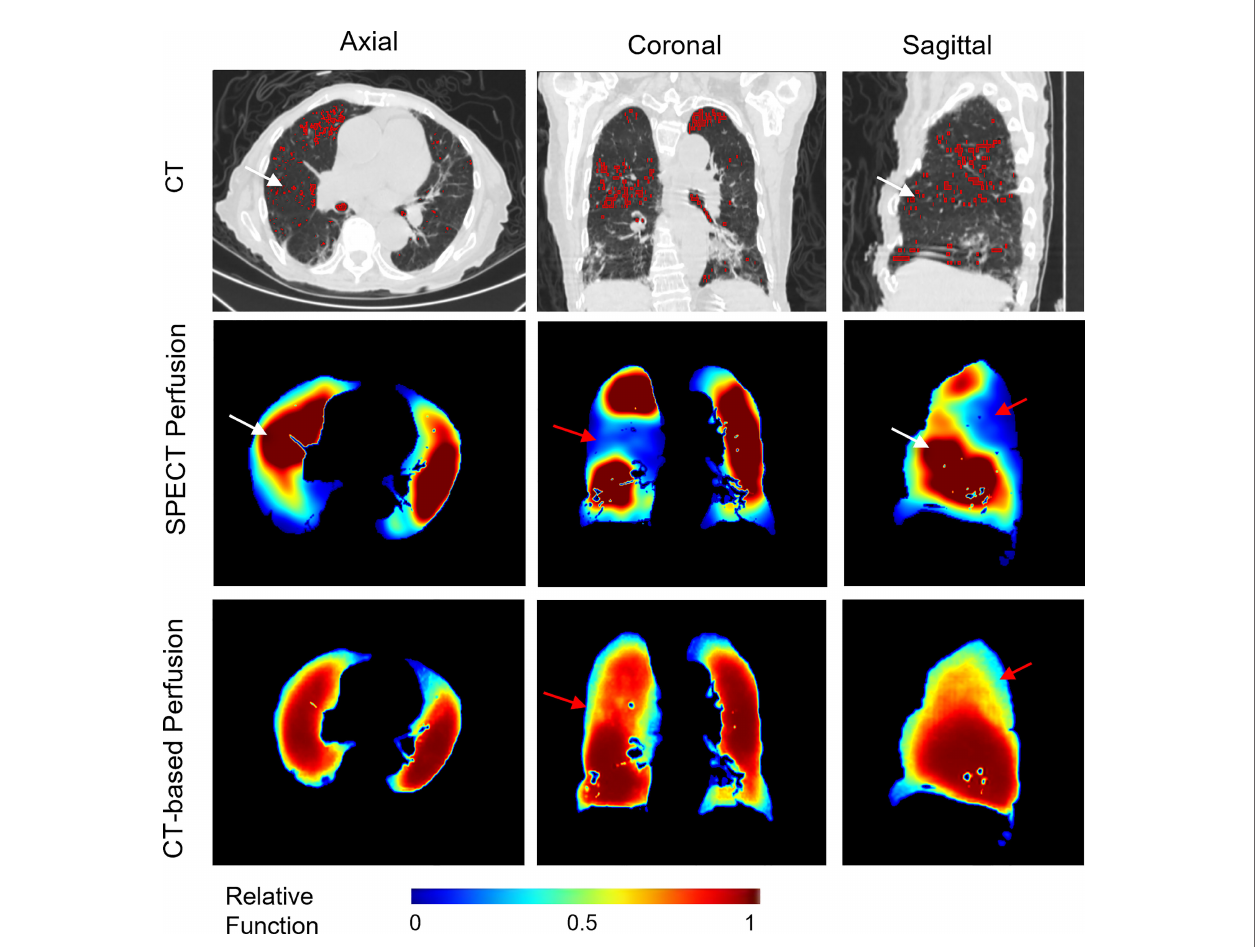
FIGURE 6 | A representative case with relatively low perfusion prediction on CT-based perfusion images. The red contours in the CT images indicate the low intensity regions (<-900 HU). The red arrows indicate the main mismatched low functional regions. The white arrows indicate the inconsistent regions between the low intensity regions of the CT images and the SPECT perfusion